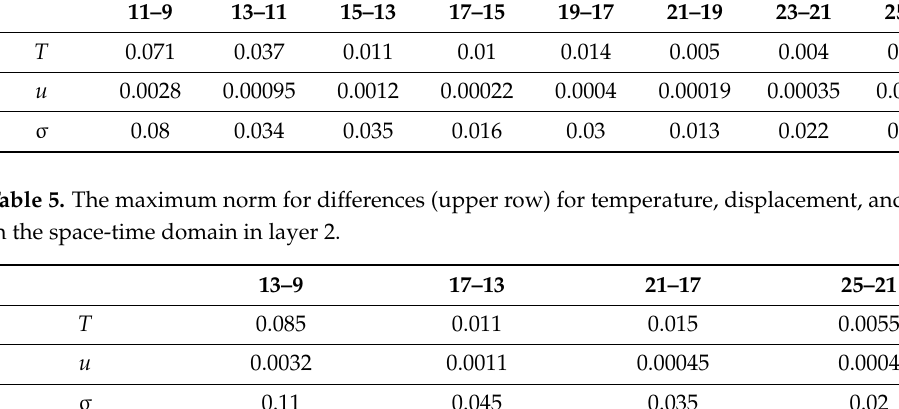
Table 4. The maximum norm for differences (upper row) for temperature, displacement, and stress in the space-time domain in layer 1.